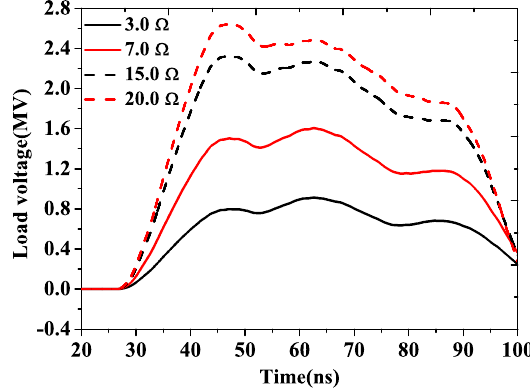
FIG. 12. Load voltage waveforms with different load imped- ance obtained by 2D circuit simulation.